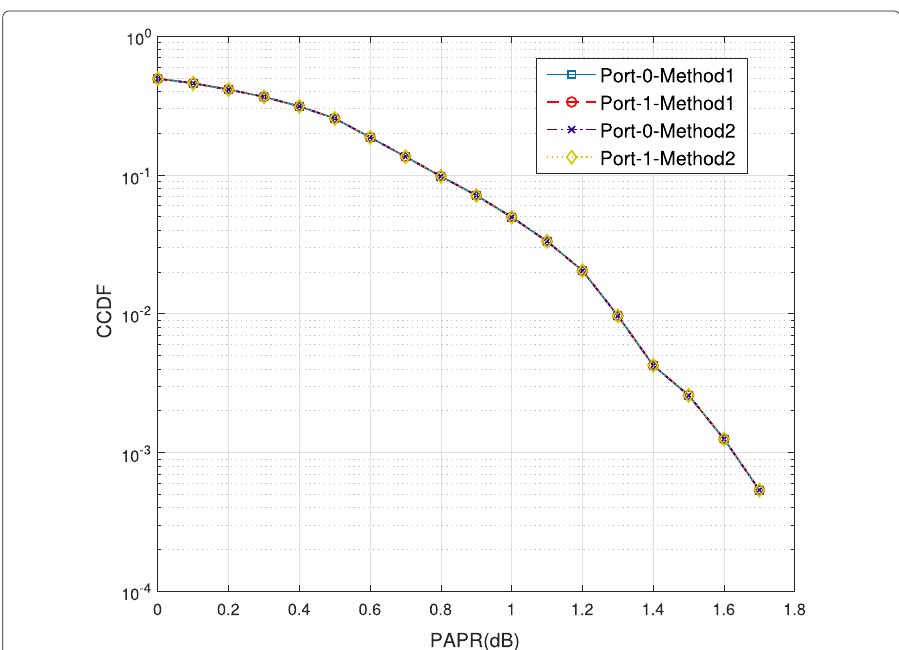
Fig. 24 PAPR comparison of length-12 DMRS sequences on port 0 and port 1 with method 1 and method 2 transmitter designs respectively